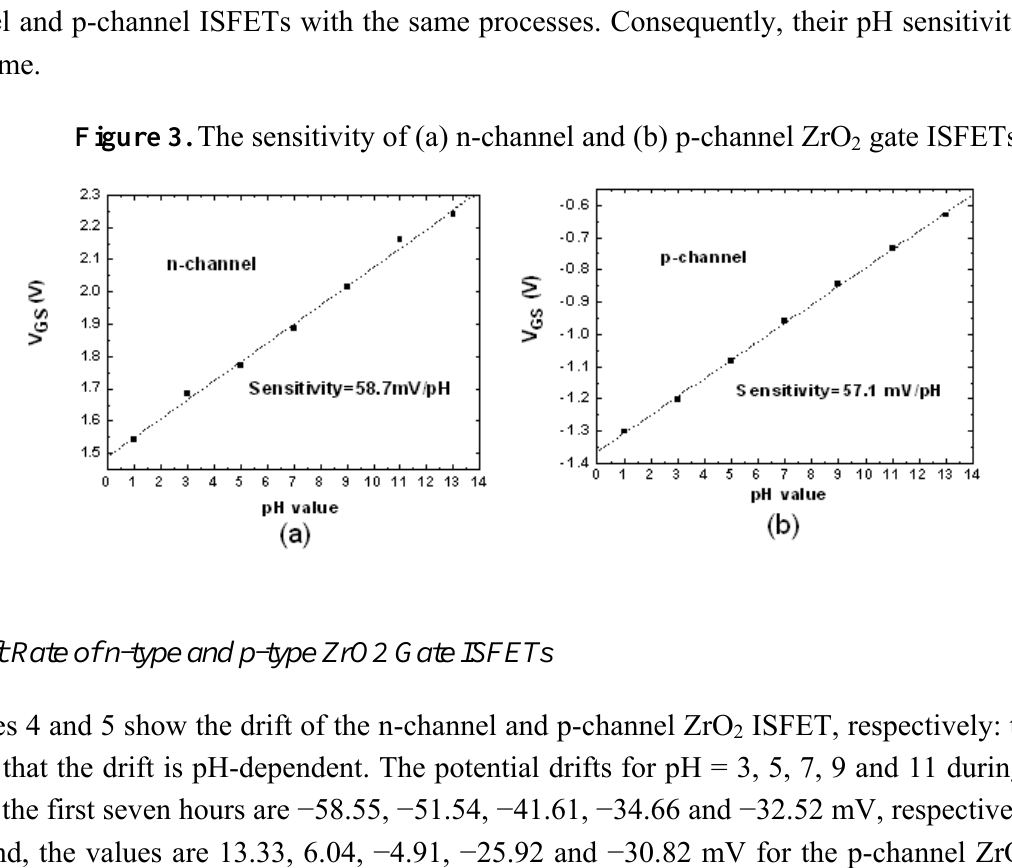
Figure 3. The sensitivity of (a) n-channel and (b) p-channel ZrO